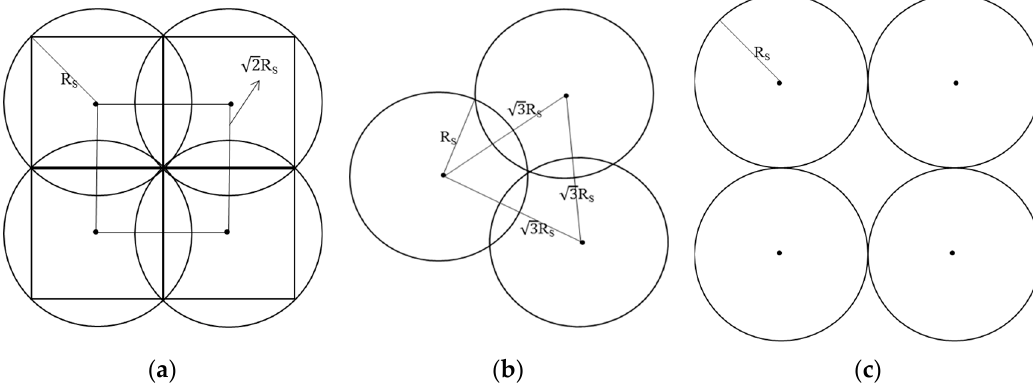
Figure 2. ( a ) The diagram of the inscribed rectangular full covering model; ( b ) the diagram of the minimum overlapping full covering model; and ( c ) the diagram of the tangent covering model of the adjacent boundary (the black point means the current location of the sensor, while the black circle means the boundary of the area sensed by the